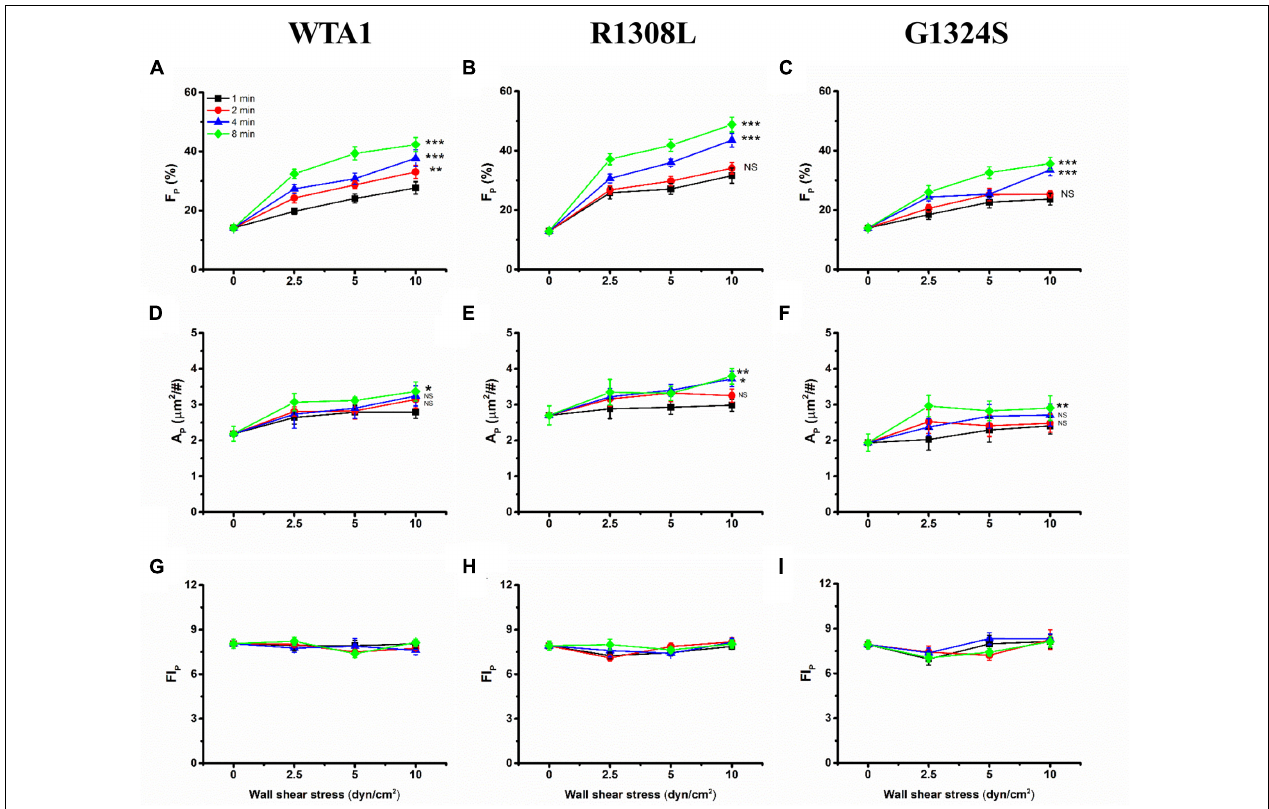
FIGURE 4 | Variations of F P , A P , and FI P of the immobilized platelets versus fluid shear stress. All the platelets on substrates coated with WTA1, R1308L, or G1324S were preloaded with fluid shear stress τ w for mechanical stimulus times of 1, 2, 4, and 8 min. The mean P-selectin-positive platelet fraction F P was plotted against fluid shear stress τ w for platelet on WTA1, R1308L, and G1324S (A–C) , respectively, and so did either the mean of P-selectin coverage area A P in (D–F) or the normalized platelet P-selectin fluorescence intensity FI P in (G–I) . All data are shown as the mean ± SEM from at least three independent experiments and analyzed by two-way ANOVA for multiple comparisons; * p < 0.05, ** p < 0.01, *** p < 0.001; NS, not significant compared with the 1-min group.